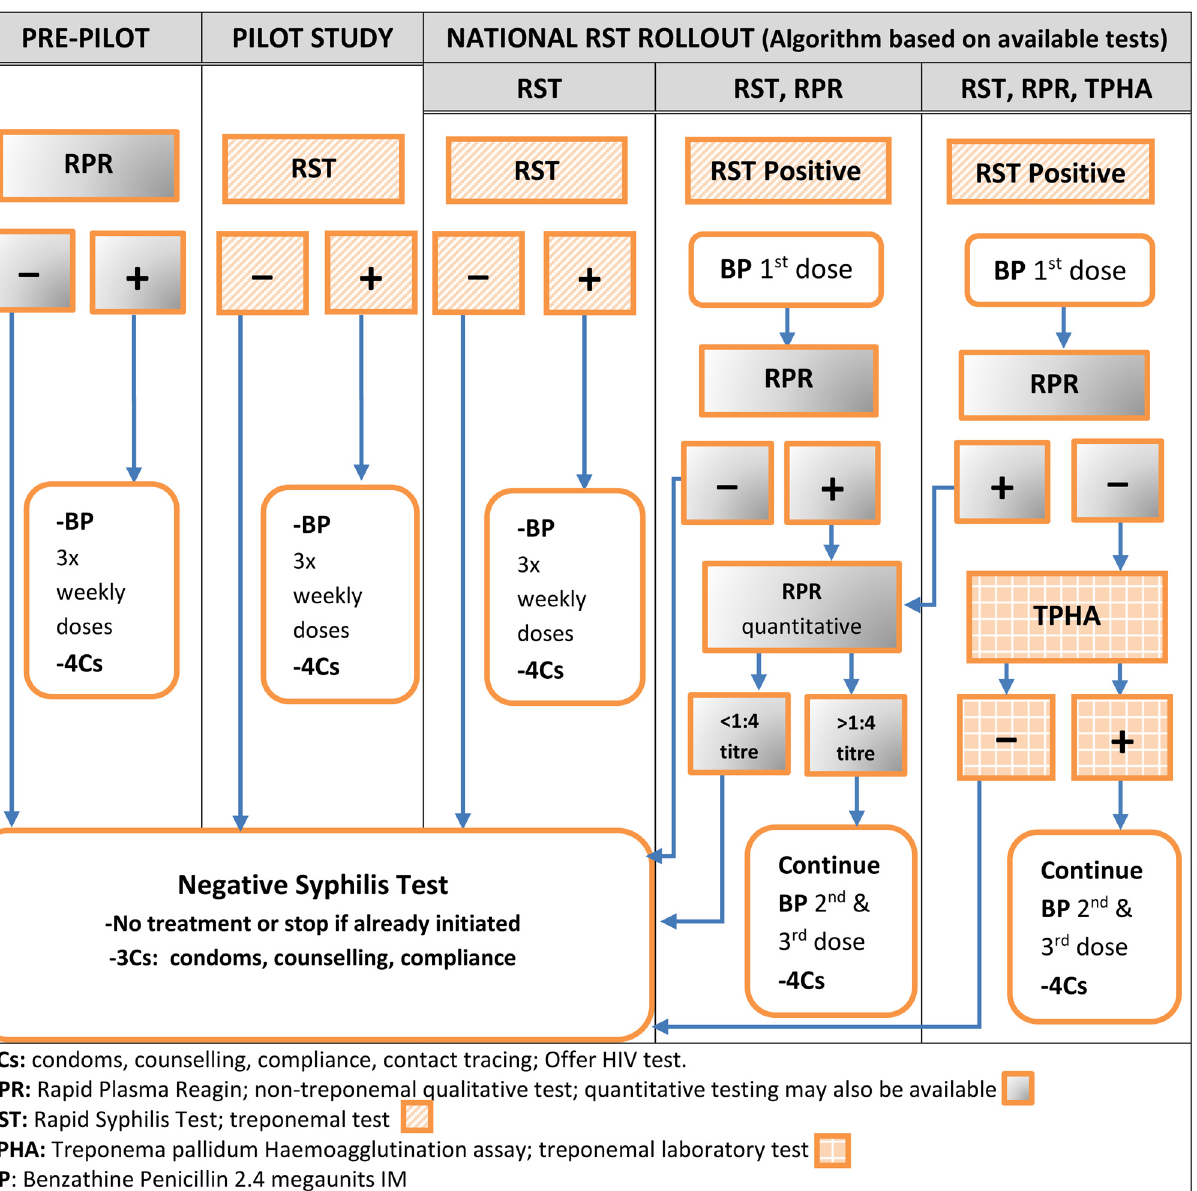
Fig 1. Phased changes in syphilis testing and treatment algorithm in Zambia 2009 – 2012. Legend: 4Cs: condoms, counselling, compliance, contact tracing, offer HIV test; RPR:Rapid Plasma Reagin; non-treponemal qualitative test; quantitative testing may also be available;RST: Rapid Syphilis Test, a treponemal test;TPHA * :Treponema pallidum Haemoagglutination assay, a treponemal laboratory test;BP: Benzathine Penicillin 2.4 megaunits IM. * The testing algorithm involving TPHA applied to tertiary care centres and was unavailable at sites included in this evaluation.